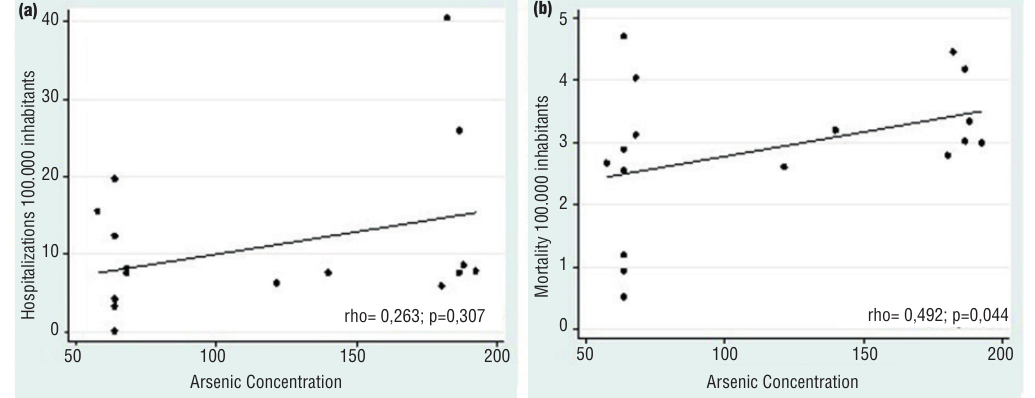
figure 1 - Association between arsenic contamination and hospitalization (a) and mortality (b) for bladder cancer in the state of São